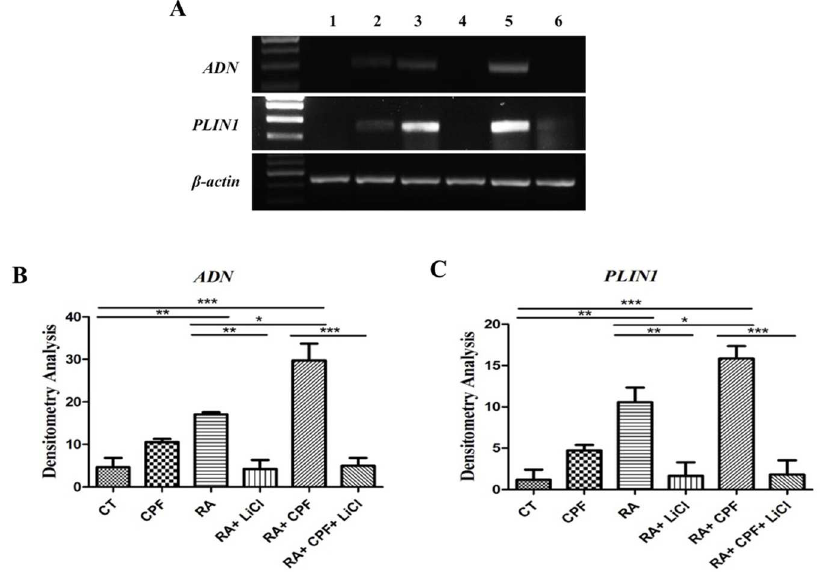
Fig 5. Adipogenic gene expression profile. (a) Electrophoretogram shows in lane (1) CT (2) 50 μ M CPF (3) 2 μ M RA (4) 2 μ M RA+10 mM LiCl (5) 2 μ M RA+50 μ M CPF (6) 2 μ M RA+50 μ M CPF+10 mM LiCl. RT PCR results showinggene expressionlevels of PLIN1 and ADN . β -actin was employedas housekeeping gene. Densitometry analysisdepicting (b) 4, 9 and 13-fold increasein PLIN1 gene expressionof 50 μ M CPF, 2 μ M RA and 2 μ M RA plus 50 μ M CPF respectively,as compared to CT. A 2-fold increasewas prevalentbetween RA and RA+CPF. (c) ADN gene expressionwas up regulated2, 4 and 6-fold in the same samples. Between RA and RA+CPF, 2-fold upregulation was observed. Treatment with LiCl resulted in completeinhibition of gene expressionof PLIN1 as well as ADN . mRNA expressionwas normalized to β -actin gene expression ( * p <